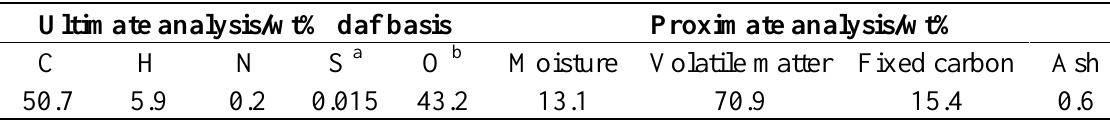
Table 3. Results of feedstock